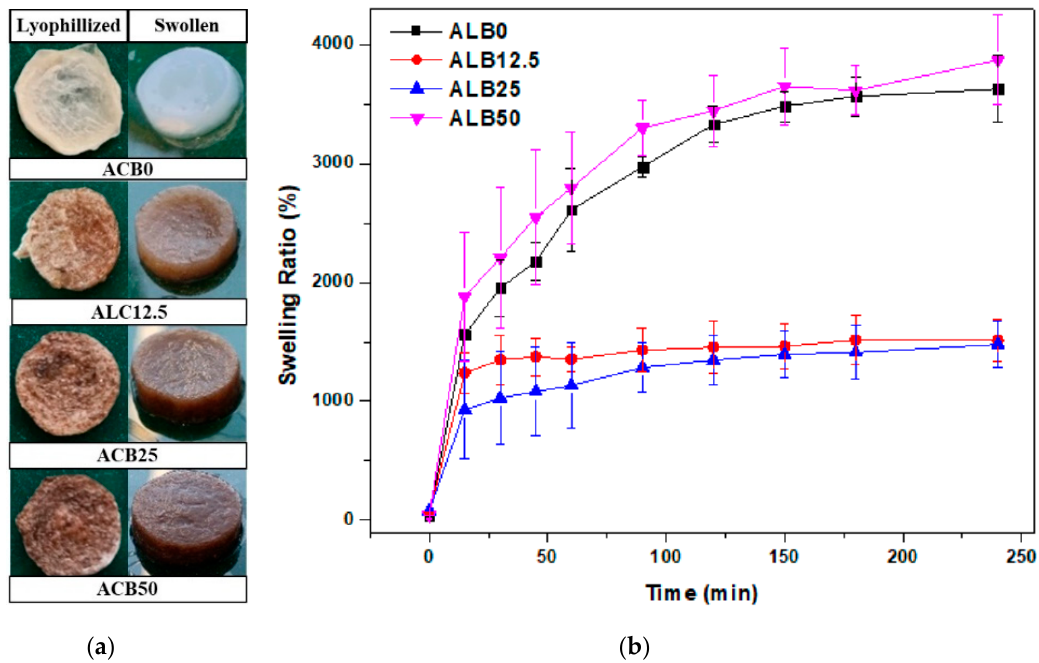
Figure 3. ( a ) Pictorial comparison between ACB hydrogels with different BCF loadings before and after swelling; ( b ) swelling kinetics of the ACB hydrogels as a function of time.